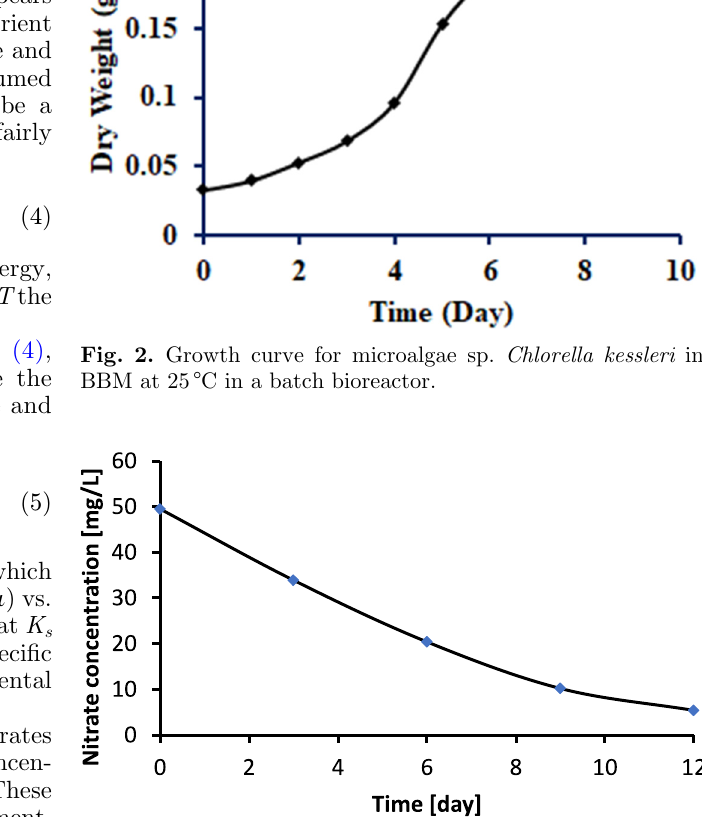
Fig. 3. Consumption of nitrate with time by Chlorella kessleri in BBM at 25 °